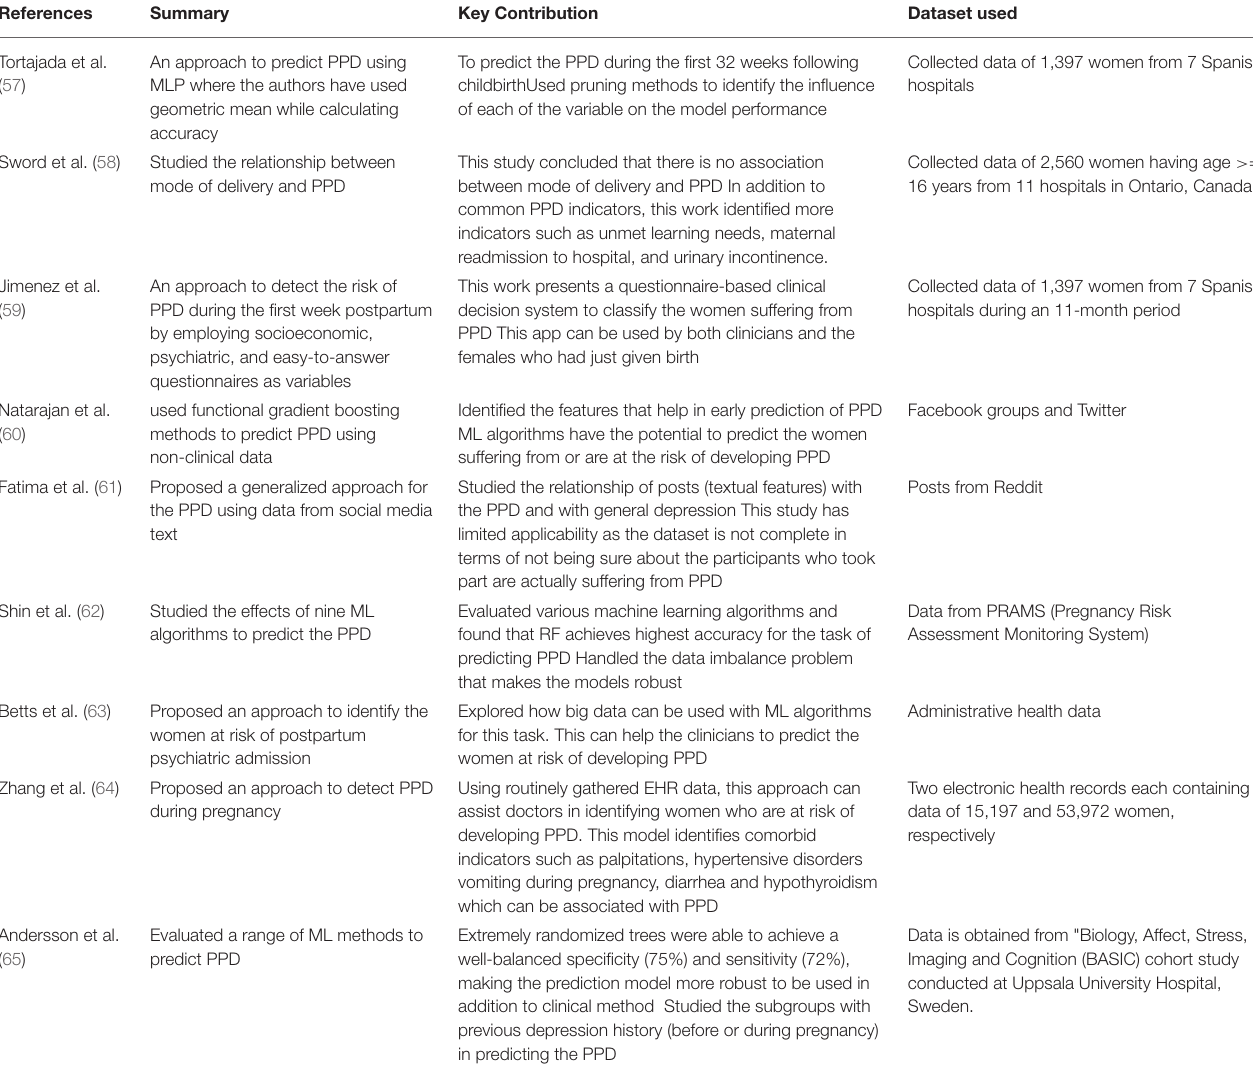
TABLE 7 | Summary of approaches used to predict postpartum depression using machine